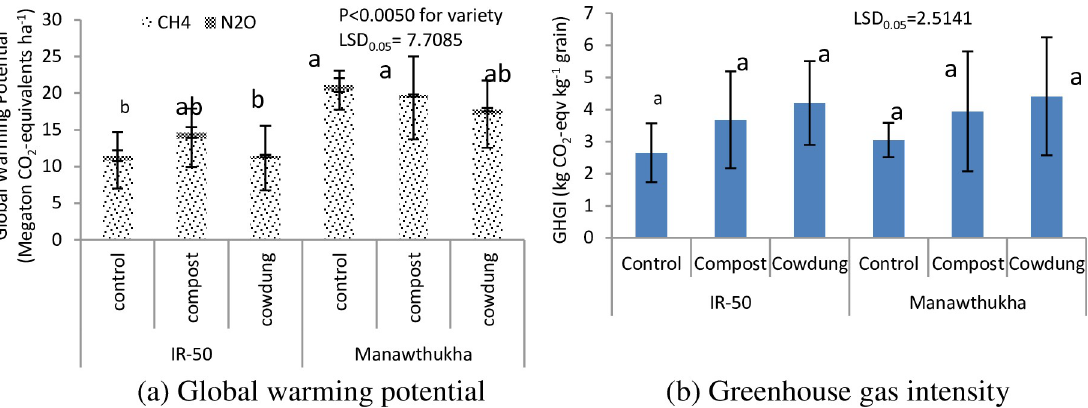
Fig 5. Effect of organic manure and rice varieties on (a) global warming potential and (b) greenhouse gas intensity during wet season, 2016. Mean value ± standard deviation (n = 3).